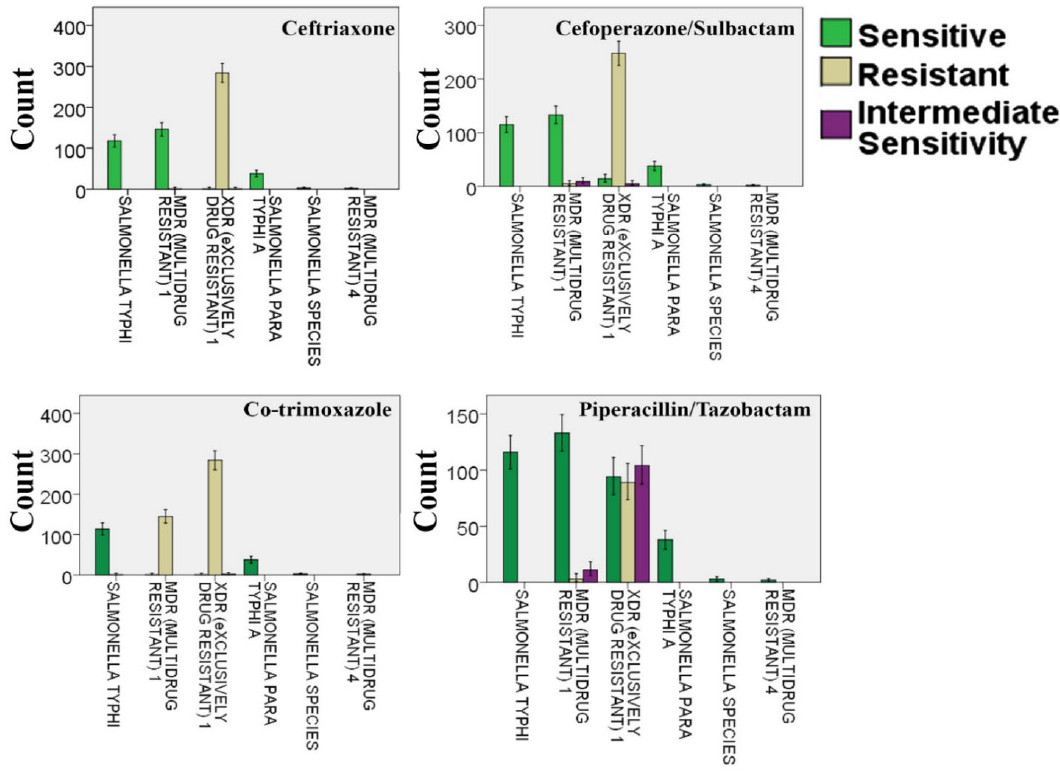
Figure 3. Resistance of Salmonella strains against ceftriaxone, cefoperazone/sulbactam, co-trimoxazole, and piperacillin/tazobactam. The bars present the number of cases with resistant, sensitive, and intermediately sensitive strains against the mentioned antibiotics whereas the error bars present a 95% confidence interval.